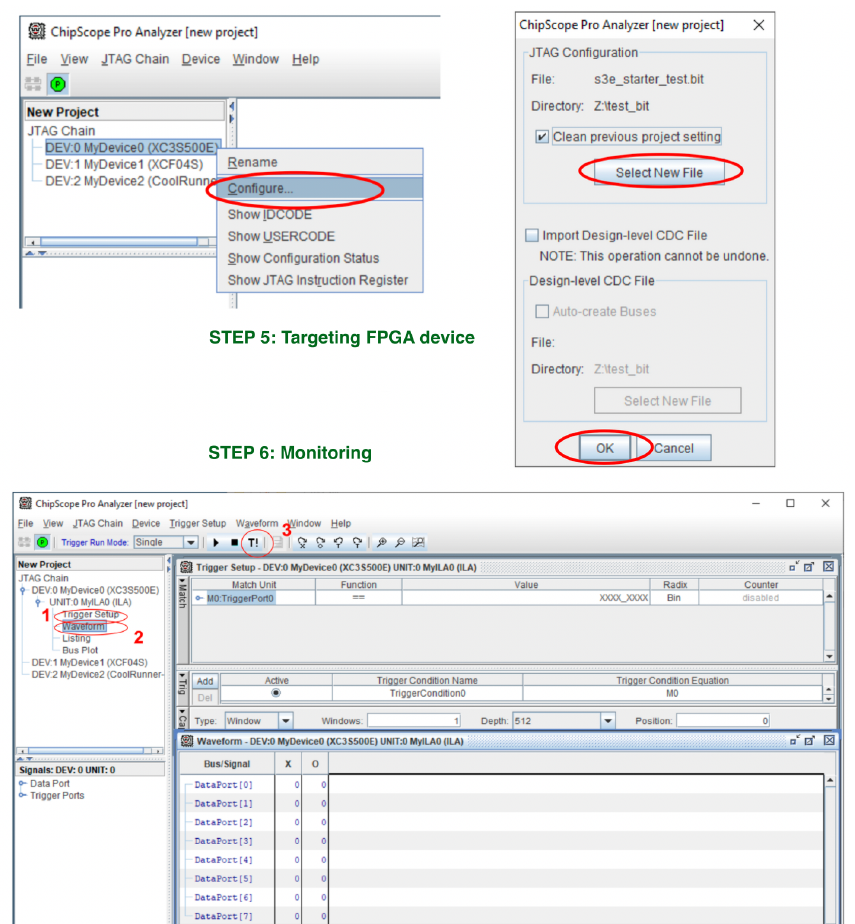
Figure 5. Remote programming and simulation. All steps are performed remotely from the students’ home computers. The detection of devices on the test board is confirmed by creating a tree with DEV0-DEV2 positions in the JTAG Chain section. The FPGA to be programmed is the XC3S500E. To simulate a test project, the following steps are needed: 1—open the trigger window, 2—open the time waveform window and 3—force the measurement trigger